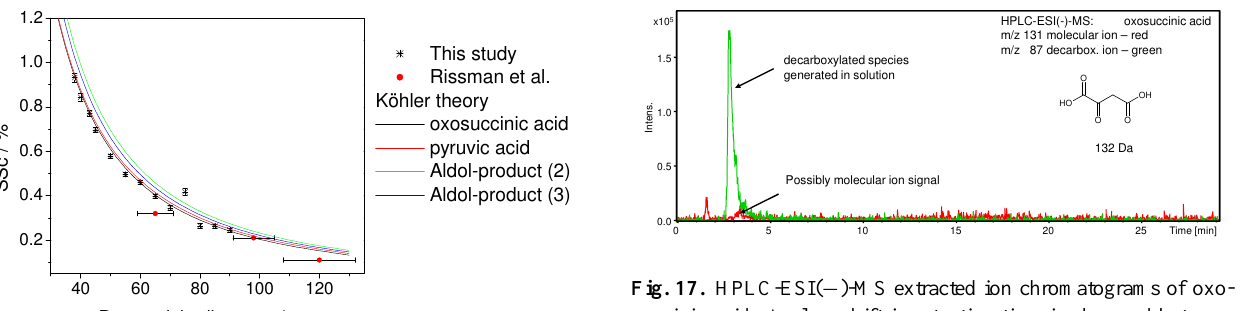
Fig. 17. HPLC-ESI( − )-MS extracted ion chromatograms of oxo- succinic acid. A clear shift in retention time is observed between the molecular ion and the decarboxylated species, indicating that oxosuccinic acid spontaneously decarboxylated in aqueous solution prior to